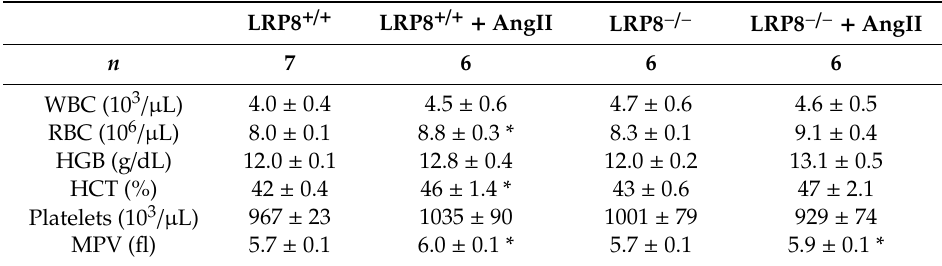
Table 1. Blood count from LRP8 +/+ and LRP8 − / − mice, sham treated or infused with AngII. LRP8 +/+ LRP8 +/+ +